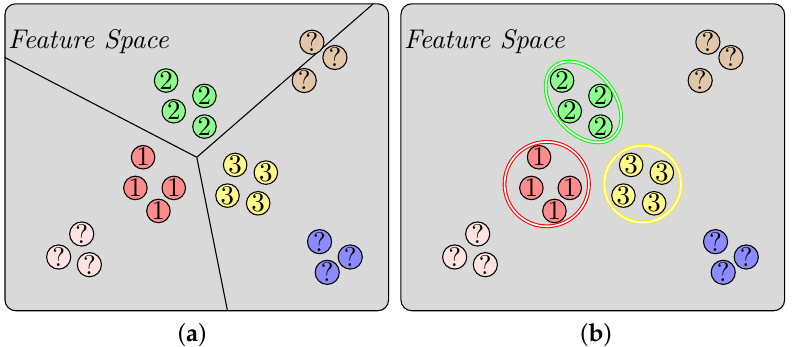
Figure 1. This figure shows the basic classification principle of CSR and OSR. Obviously, the half- open classification boundary in the CSR model cannot handle the open set problem, and the closed classification boundary is more suitable for OSR. ( a ) CSR, ( b )